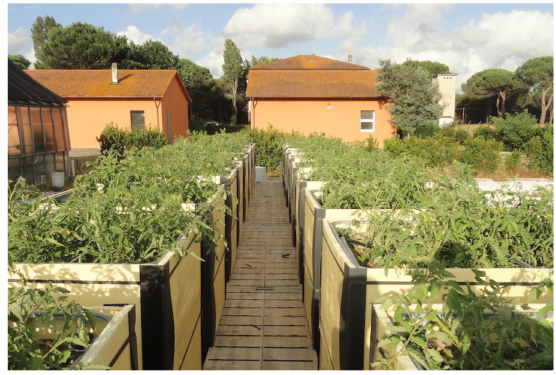
Figure 5. Improvement of the tomato yields, due to the reduction of the negative e ff ect of sodium after BOF slag